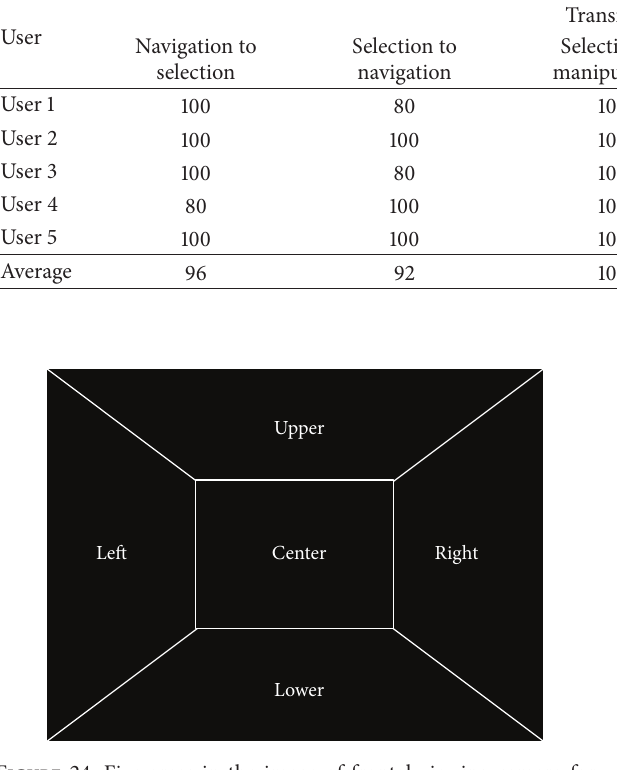
Figure 24: Five areas in the image of frontal viewing camera for discriminating the user’s gaze direction in the navigation